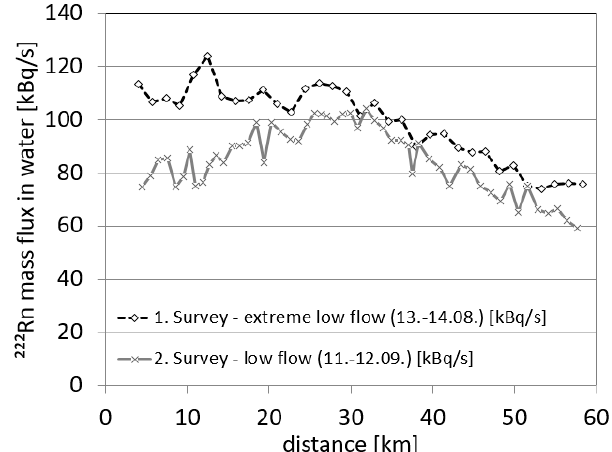
Figure 8. 222 Rn mass flux [kBq / s] in the river water between Schmilka (km 0) and Pieschen (km 60) as Figure 8. ²²²Rn mass flux [kBq/s] in the river water between Schmilka (km 0) and Pieschen (km 60) as detected from the cruising vessel during the two detected from the cruising vessel during the two surveys.